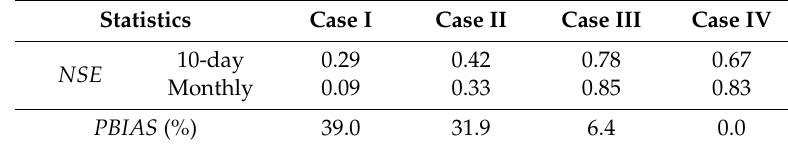
Figure 6. Scatter plots of observed vs. simulated agricultural water supply. Table 5. Model simulation statistics for parameter-selection schemes.